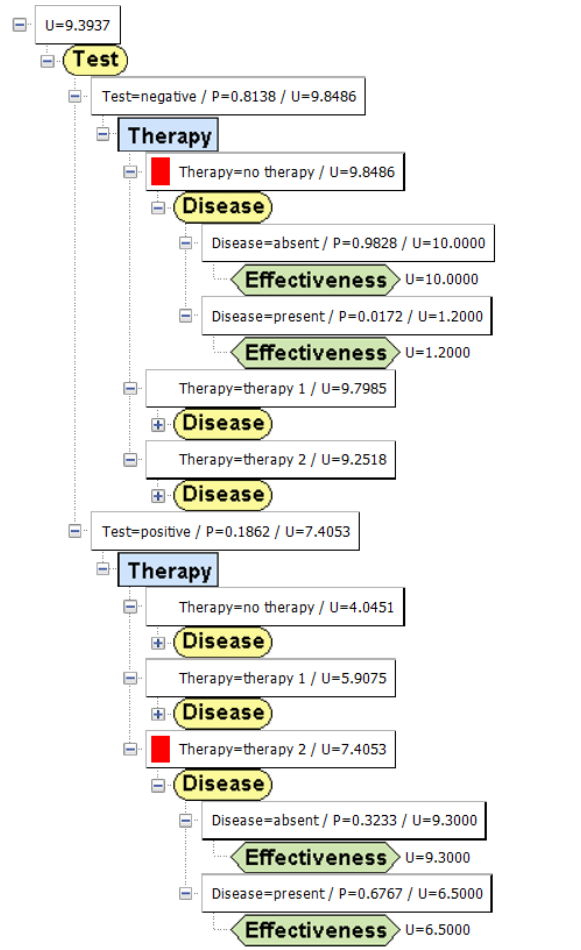
Figure 7. A decision tree equivalent to the ID in Figure 6. A red rectangle denotes the optimal choice for each decision. Some branches have been collapsed to make the figure more